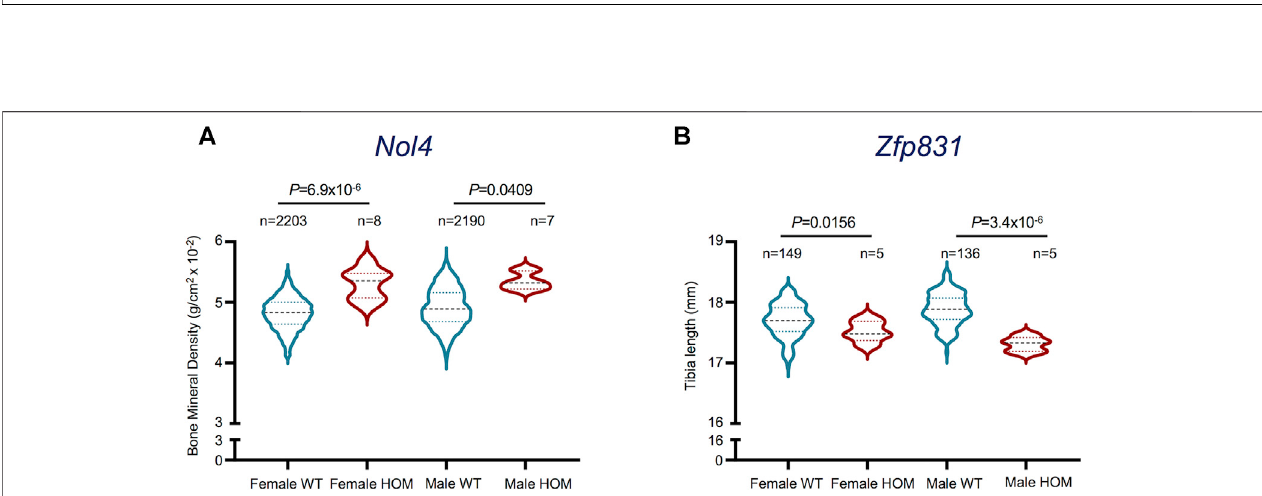
Frontiers in Genetics |